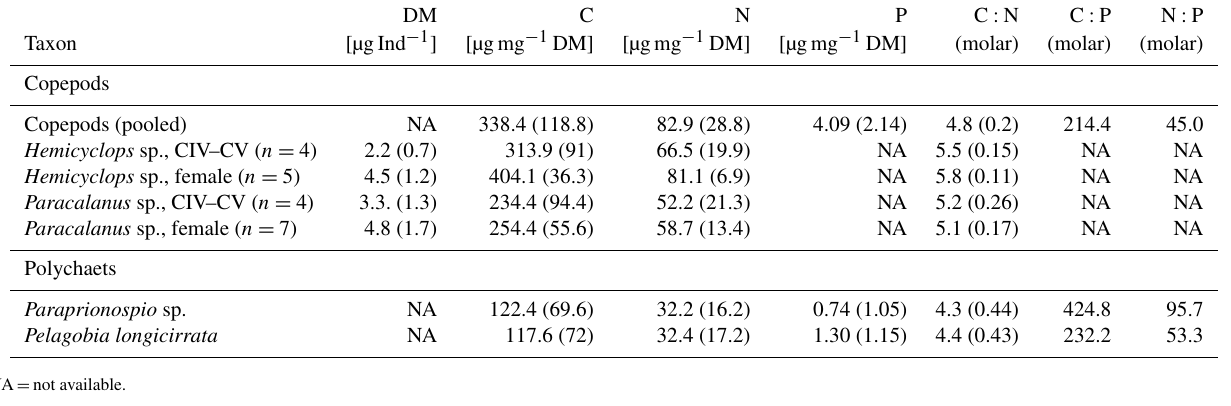
Table 4. Mean and standard deviation (SD) of dry mass (DM), carbon, nitrogen, and phosphorus content of dominant mesozooplankton taxa as well as their molar ratios.